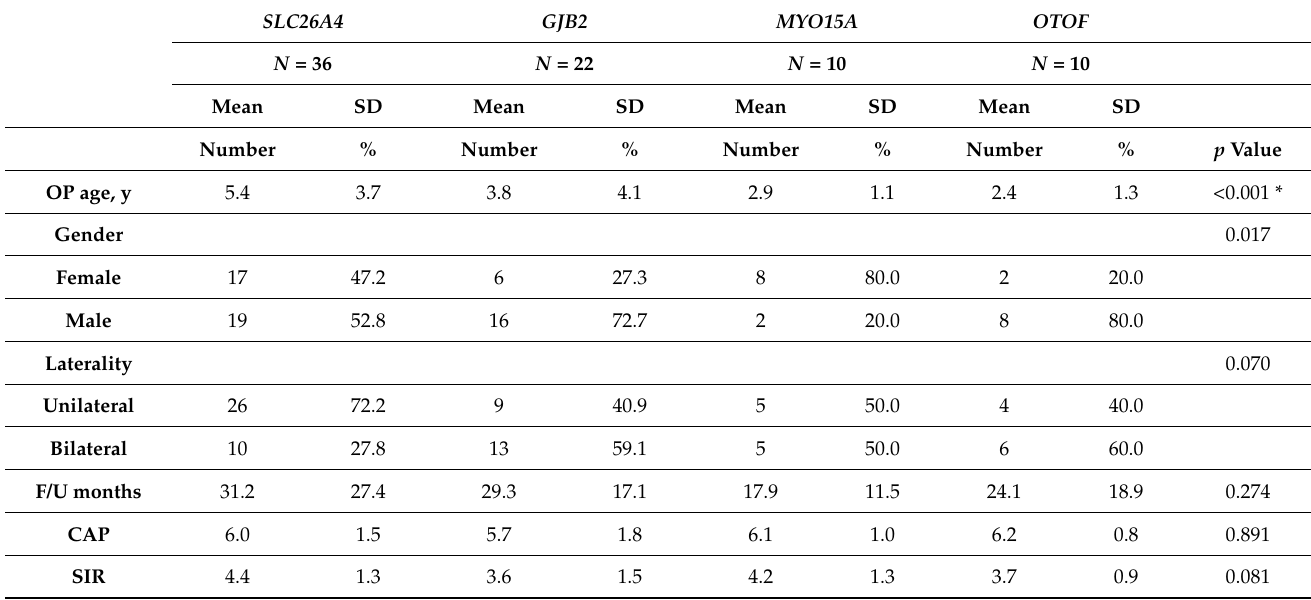
Table 3. Subgroup analyses in patients with pathogenic variants in the four predominant non- syndromic SNHI